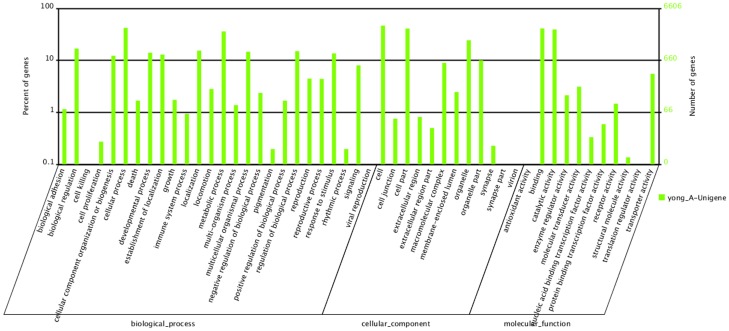
Histogram presentation of the gene ontology classification.The right y-axis indicates the number of genes in a category, whereas the left y-axis indicates the percentage of a specific category of genes in that main category.